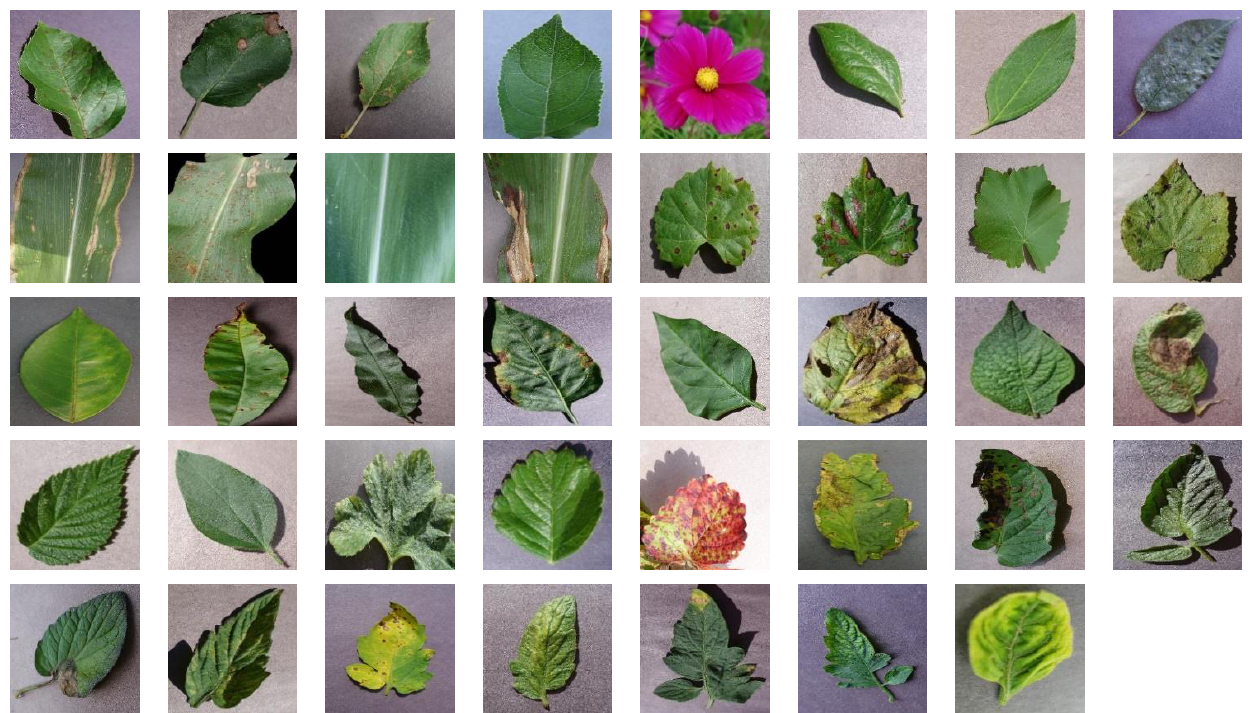
Figure 4. Example images of each of the 39 classes in the small PlantVillage dataset. The order of classes (left to right, top to bottom) corresponds to the labels (from left to right) in Figure 3.